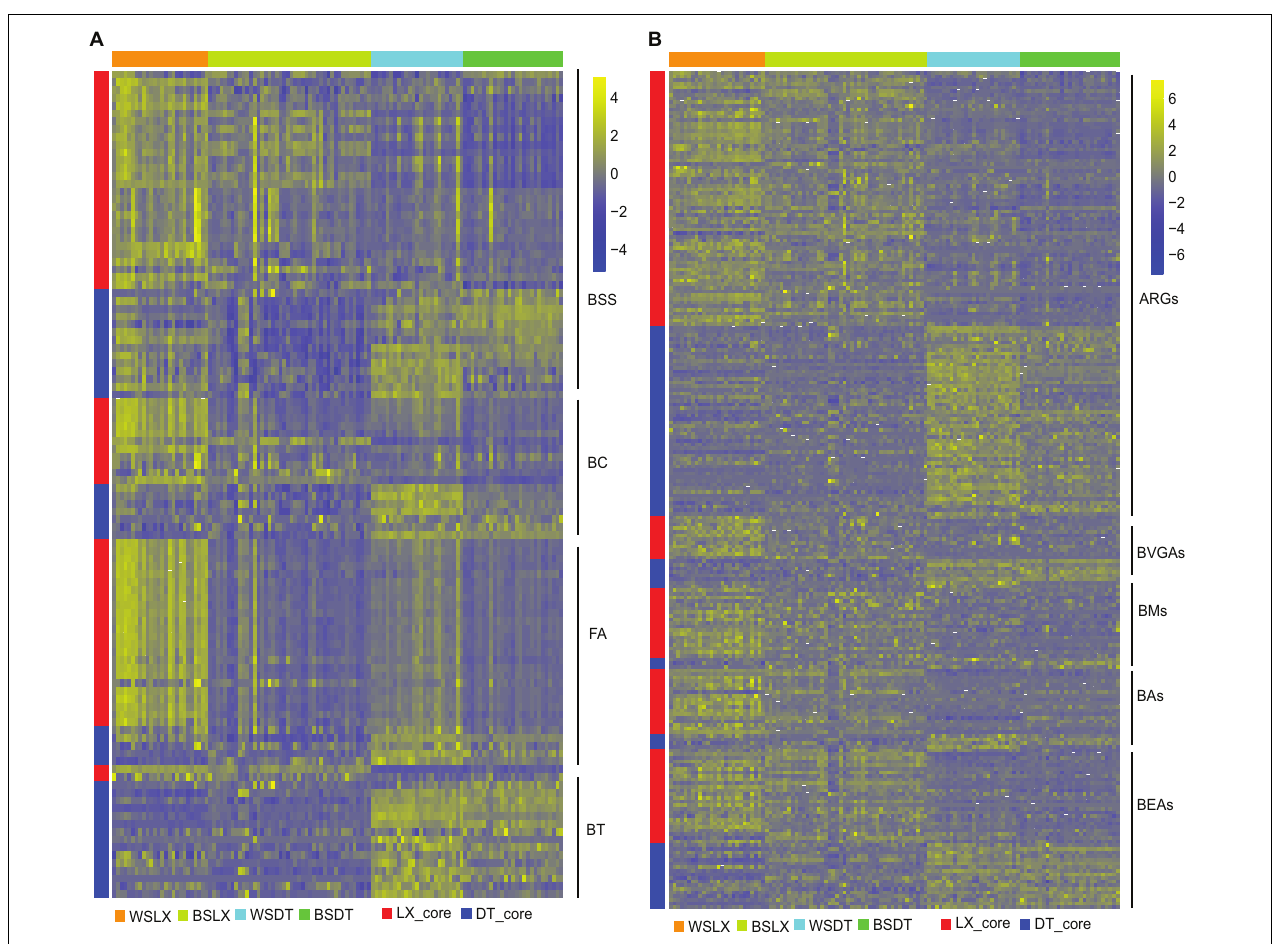
FIGURE 10 | Relative abundances of core rhizosphere KOs in different planting patterns. (A) The relative abundance of core rhizosphere KOs involved in plant–microbe and microbe–microbe interactions. (B) The relative abundance of core rhizosphere KOs involved in antimicrobial resistant genes (ARGs), antibiotic synthesis genes (ASGs). Scale, relative abundance of KO at row normalization by removing the mean (centering) and dividing by the standard deviation (scaling). The color from blue to yellow represents a relative abundance of each KO from low to high. WSDT, rhizosphere soil of cropland planting in Wenshan City; WSLX, rhizosphere soil of understory planting in Wenshan City; BSDT, rhizosphere soil of cropland planting in Baise City; BSLX, rhizosphere soil of understory planting in Baise City; BSS, bacterial secretion systems; BC, bacterial chemotaxis; FA, flagellar assembly; BT, bacterial toxins; ARGs, antimicrobial resistant genes; BVGAs, biosynthesis of vancomycin group antibiotics; BMs. biosynthesis of 12-, 14-, and 16-membered macrolides; Bas, biosynthesis of ansamycins; BEAs, biosynthesis of enediyne